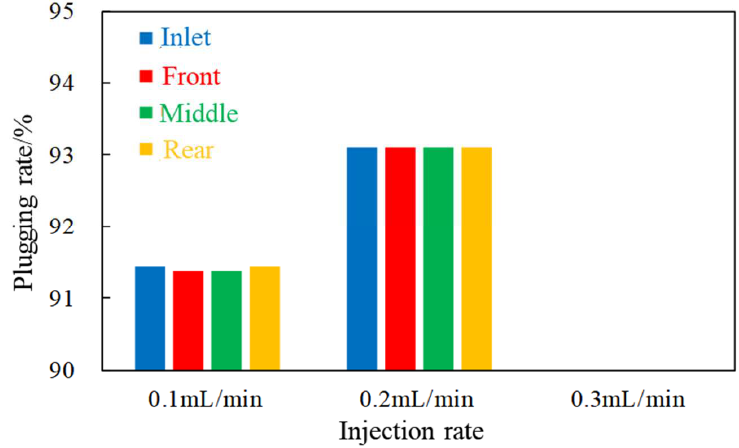
Figure 9. The plugging rates of different positions under different injection rates.